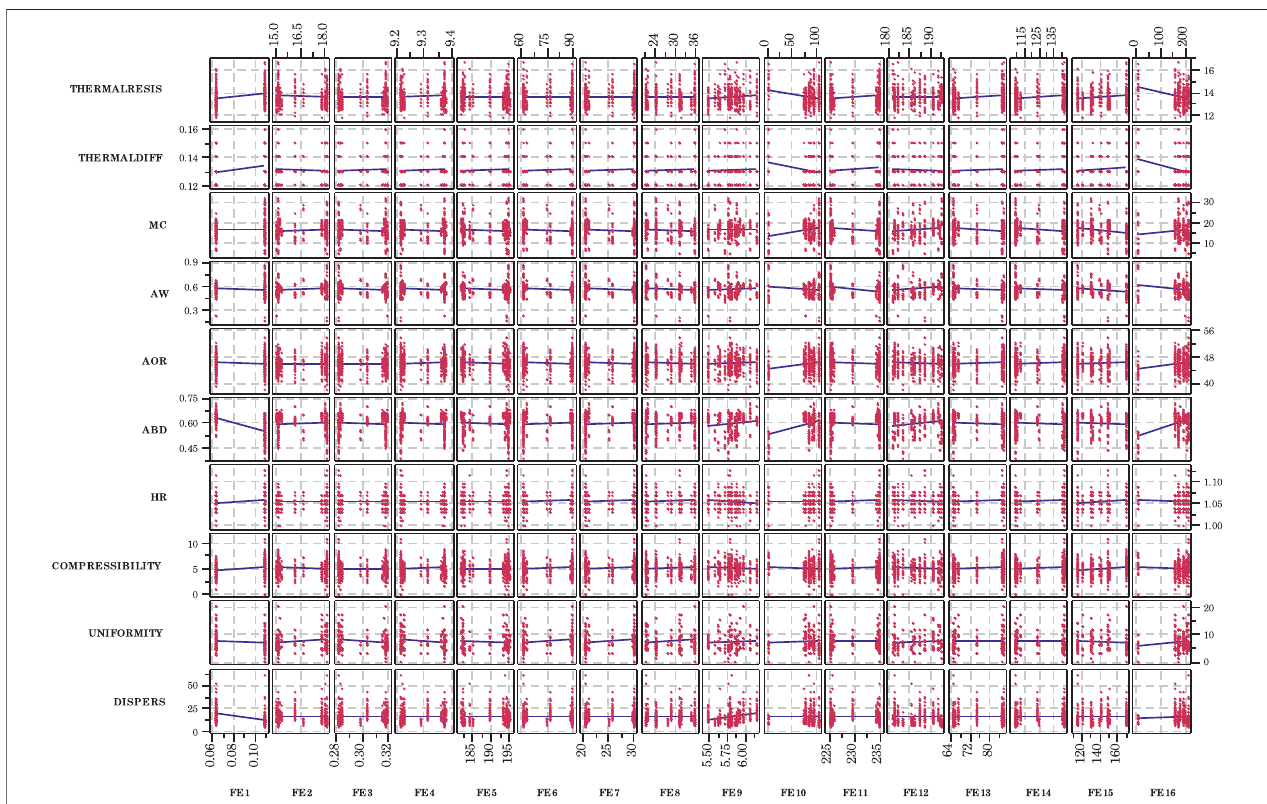
FIGURE 3 | Scatterplots of dependent variables for each front end independent variable. Although considerable scatter is present, some linear trends appear pronounced. Variable de fi nitions provided in Tables 1, 2